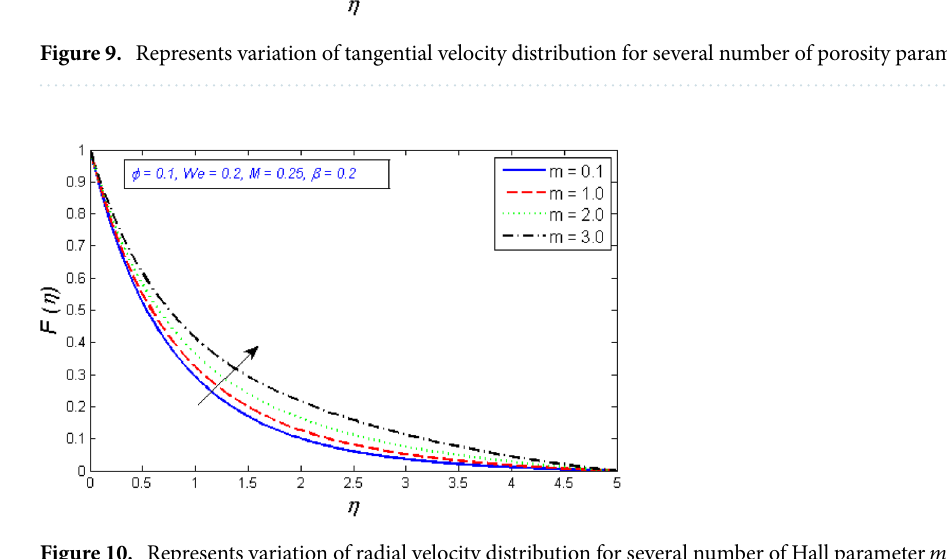
Figure 10. Represents variation of radial velocity distribution for several number of Hall parameter m